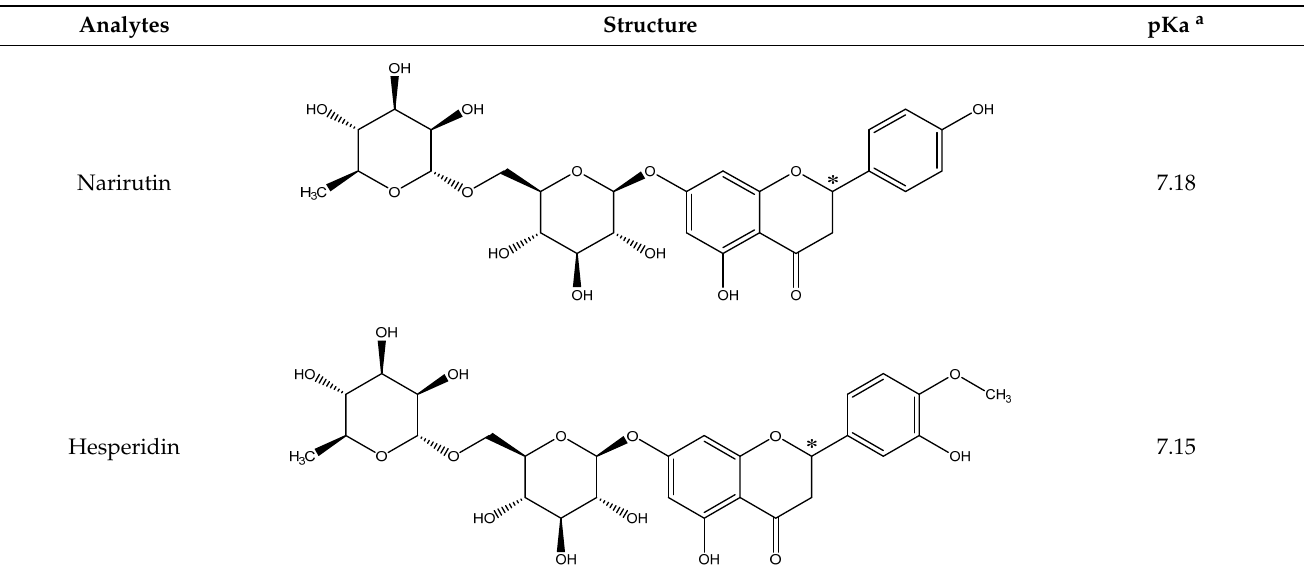
Table 1. The chemical structures and pKa values of two